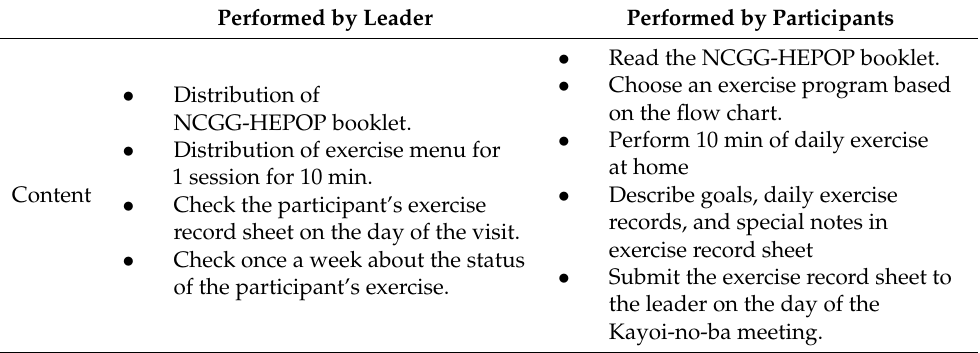
Table 1. Overview of the intervention program. Performed by Leader Performed by